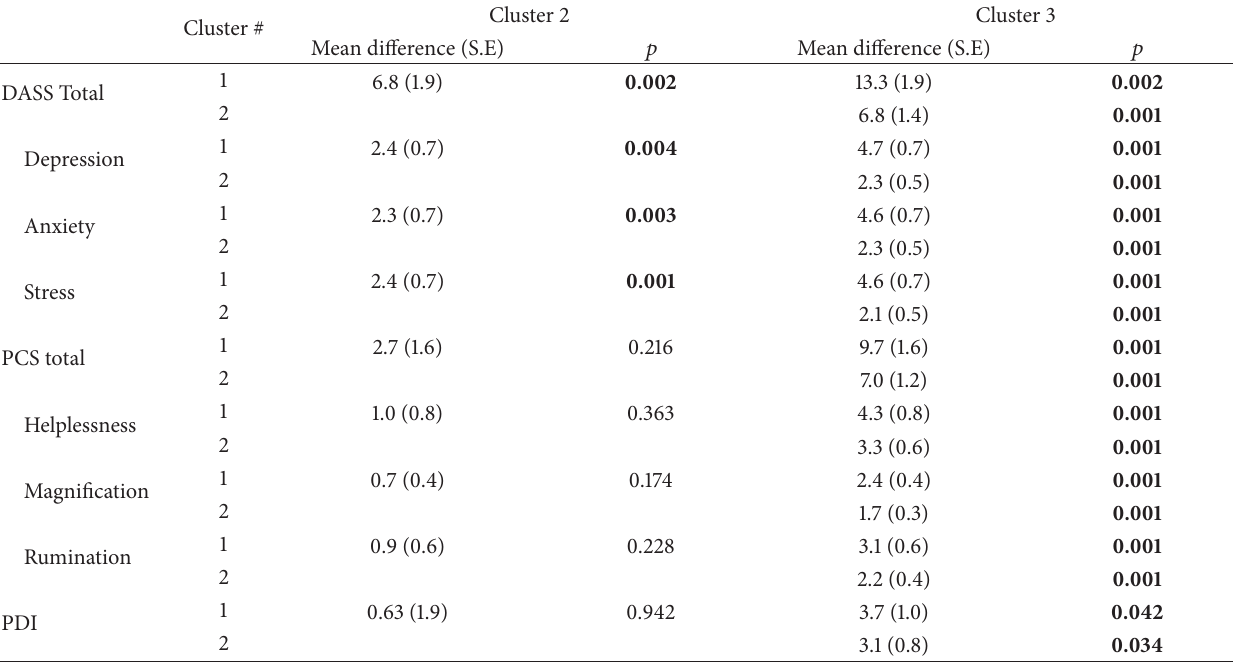
Table 3: Post hoc analysis mood, pain catastrophizing, and pain disability among clusters